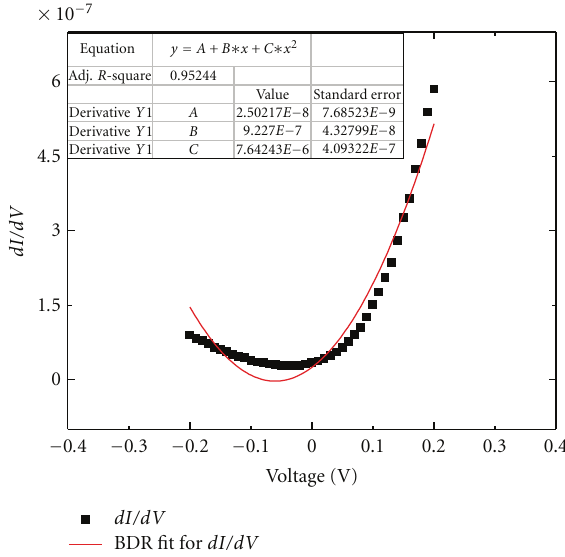
Figure 5: dI/dV of Ti-TiO 2 (native)-Al MIM diode with fitted parabola.